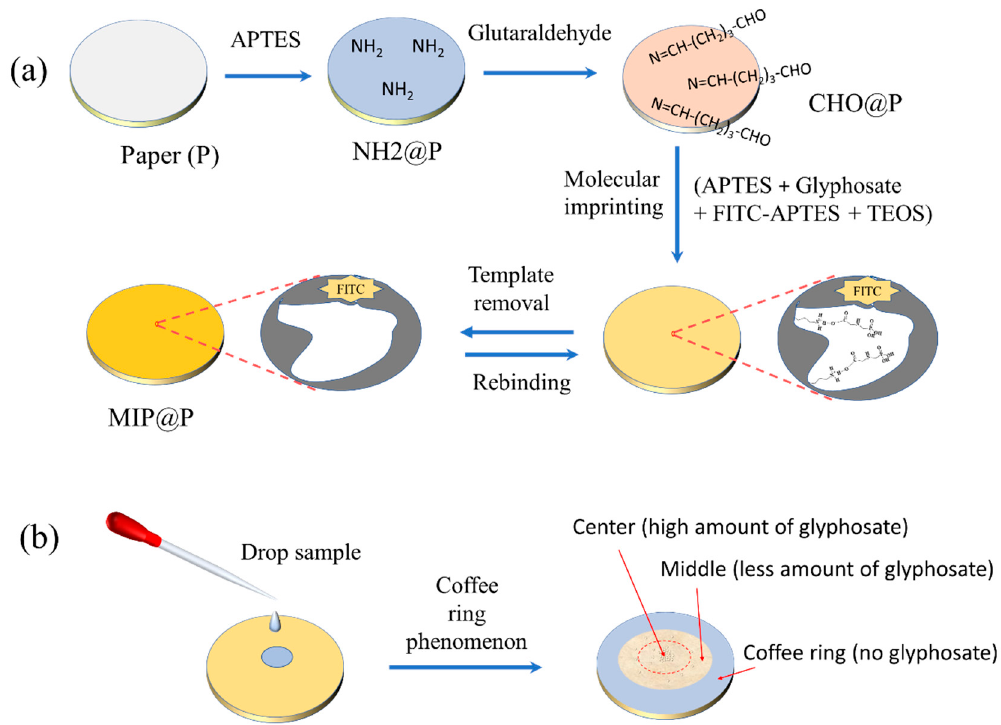
Figure 1. Preparation of fluorescent MIP@P for specific recognition of glyphosate ( a ) sensitively based on the coffee ring phenomenon ( b ).